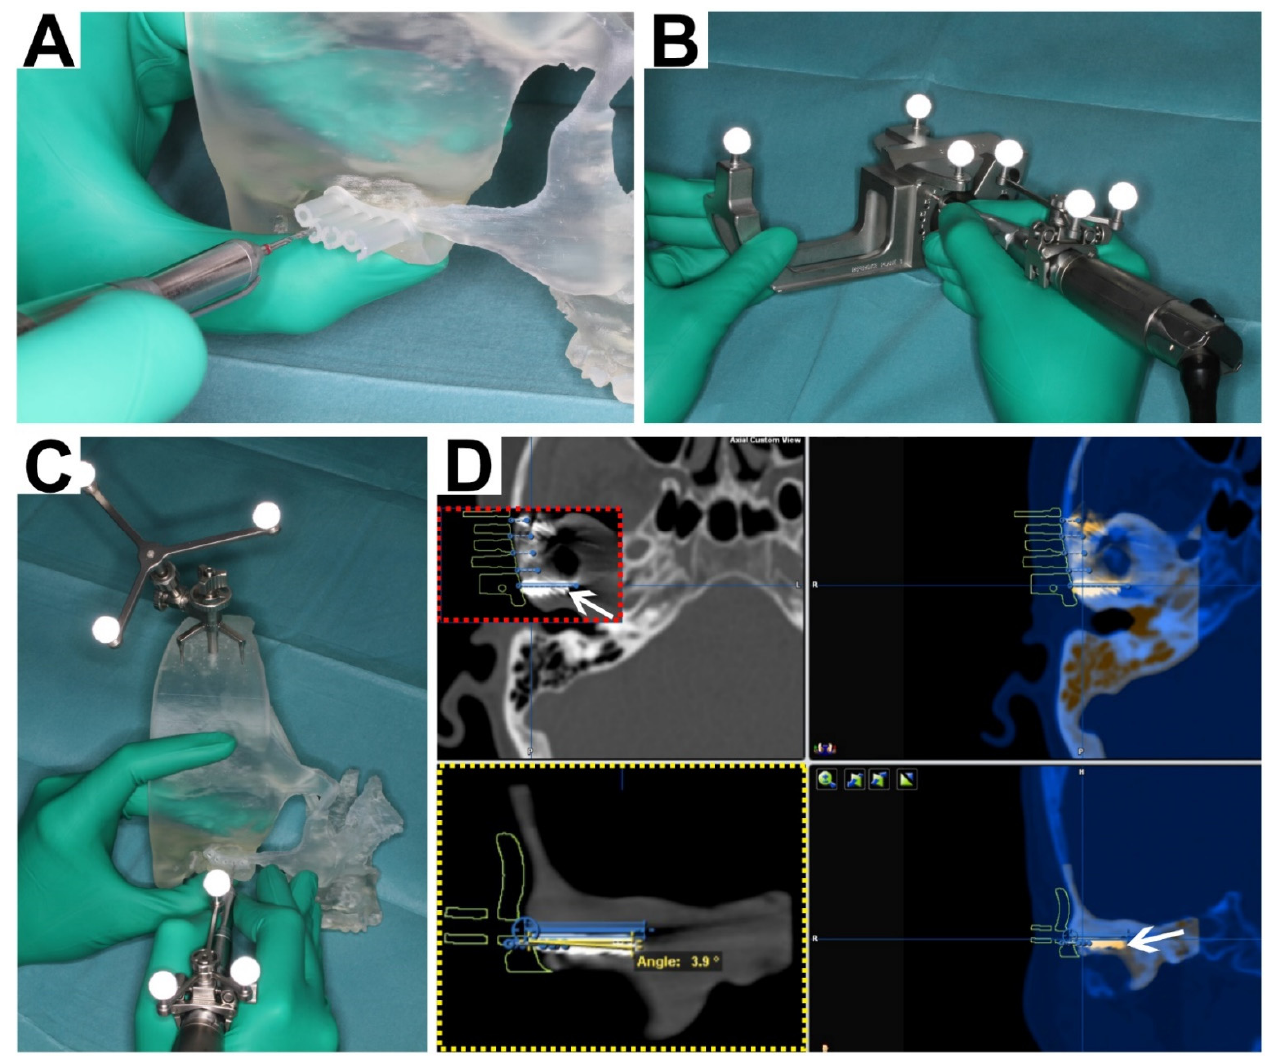
Figure 2. Performing model surgery with and without navigation. ( A ) Guided surgery with advanced drilling guide (group 1) for vector and length control in a patient model of the right TMJ. ( B ) Referencing and setup of navigational instrument/drill-tracking (Brainlab ® Kick, Brainlab, Munich, Germany). ( C ) Navigation-tracked drilling for vector and length control using a simple drilling guide. ( D ) Superimposition of preoperative computed tomography dataset, containing the virtual surgical planning, with the postoperative cone beam computed tomography scan of the surgery model. Drill holes were filled with radiopaque root canal sealer (white arrows). Red Box: Planned screw vectors (blue lines with dots on each end). The screw head position [mm], drilling length [mm] and vector [degree] (yellow box) were measured (yellow lines) for deviation from the virtual surgical plan (blue vector).